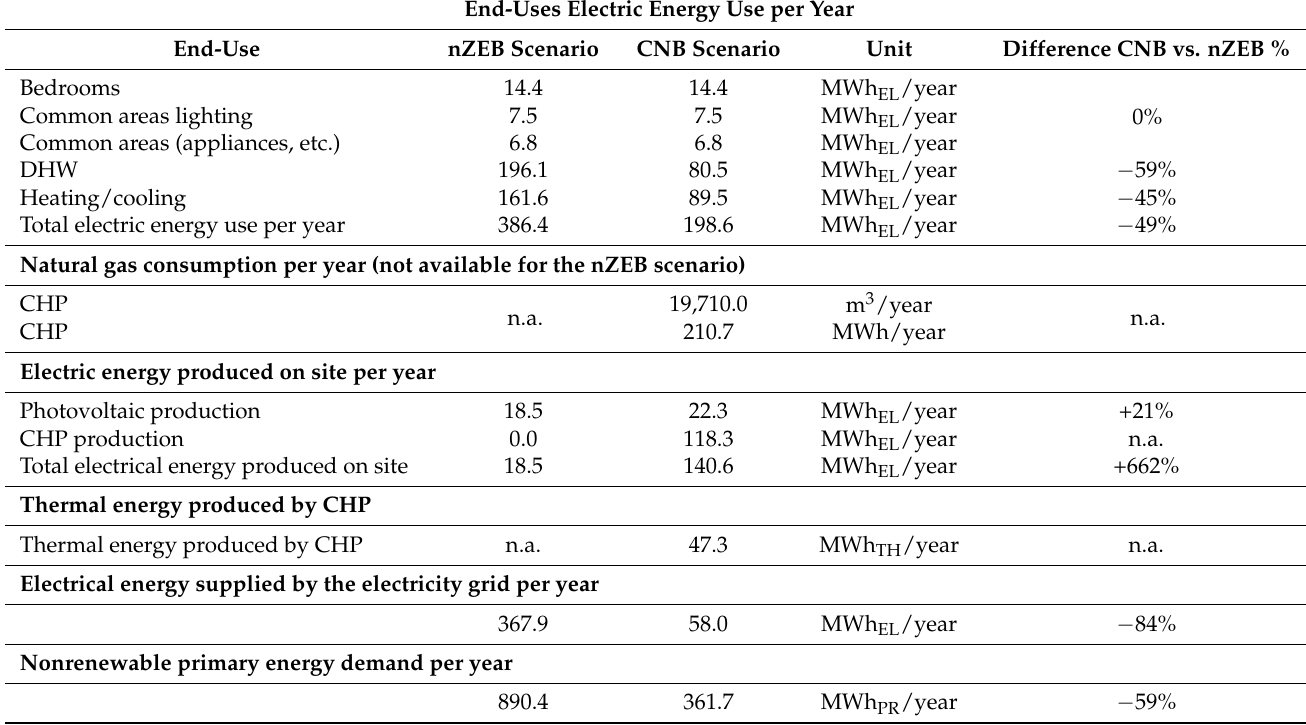
Table 4. nZEB and CNB energy performance per